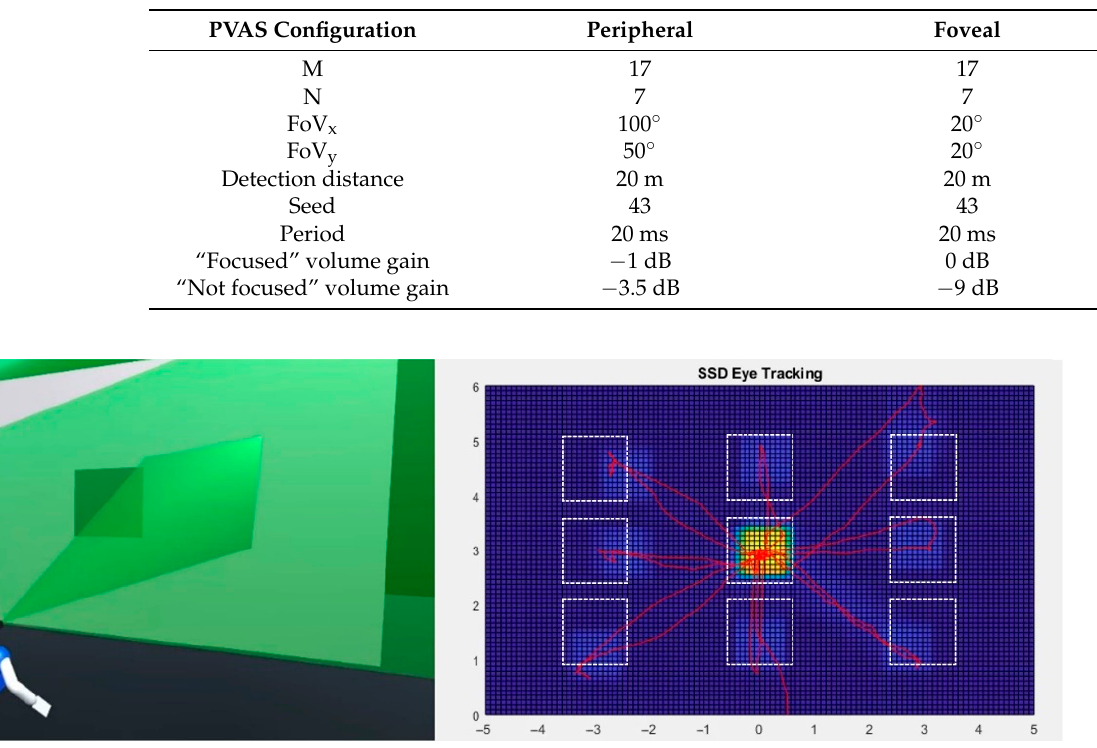
Figure 4. Test of search and focus a moving element. In the right image, mock SSD eye tracking is presented.